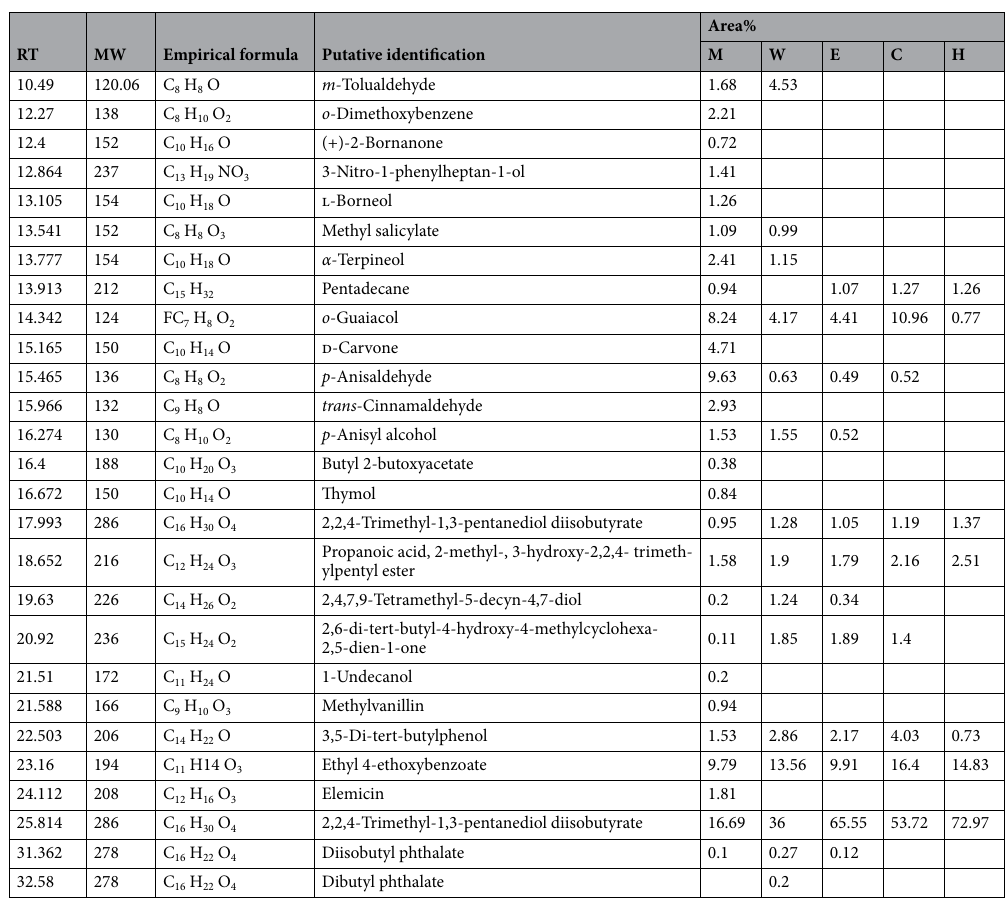
Table 2. Qualitative GC–MS headspace analysis of the T. impetiginosa bark extracts, elucidation of empirical formulas and putative identification of each compound. RT retention time, MW mass weight, M methanol extract, W water extract, E ethyl acetate extract, C chloroform extract, H hexane